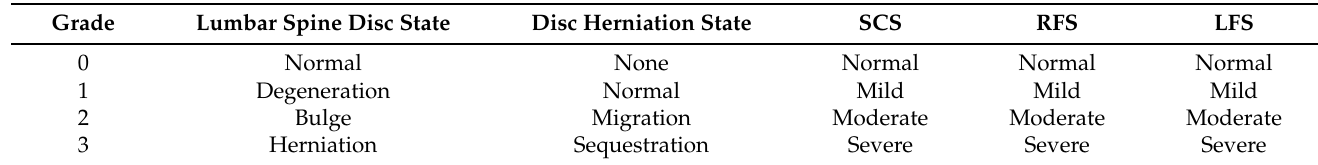
Table 3. The selection criteria of the lumbar disc axial view T2 image.